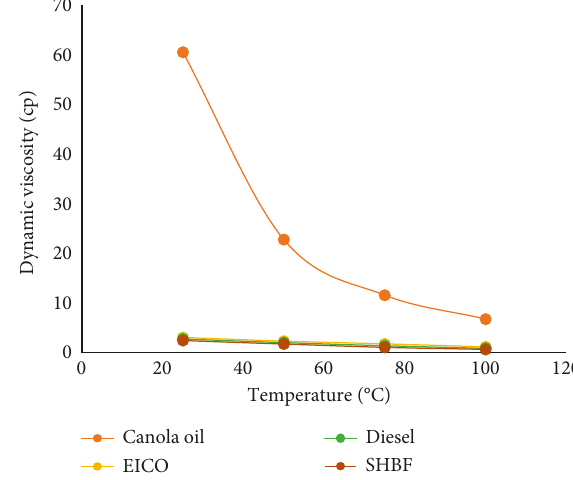
Figure 4: Dynamic viscosity variation with temperature. Table 6: Surface tension of fluid samples at 25 ° C.